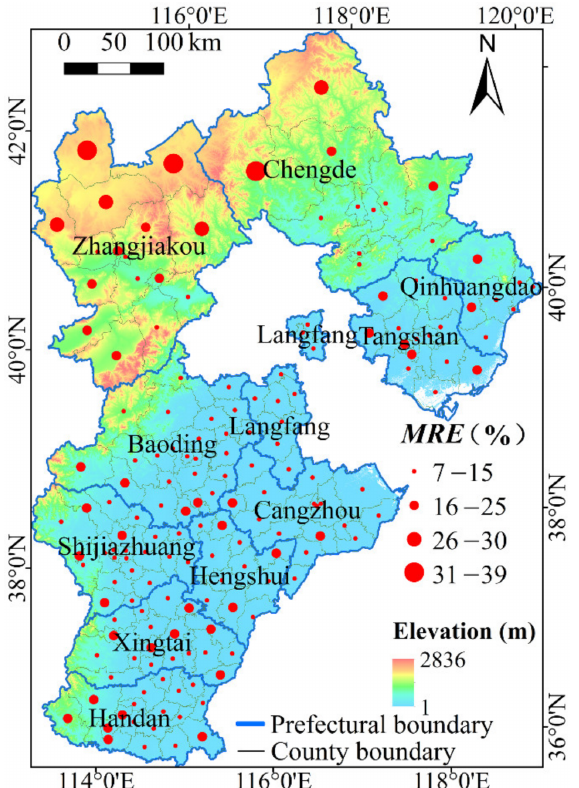
Figure 5. The MREs of predicted quarterly GDP for 167 county-level cities in Hebei province. Table 2. Quarterly new COVID-19 cases in prefecture-level cities in Hebei Province from 2020 to 2021.